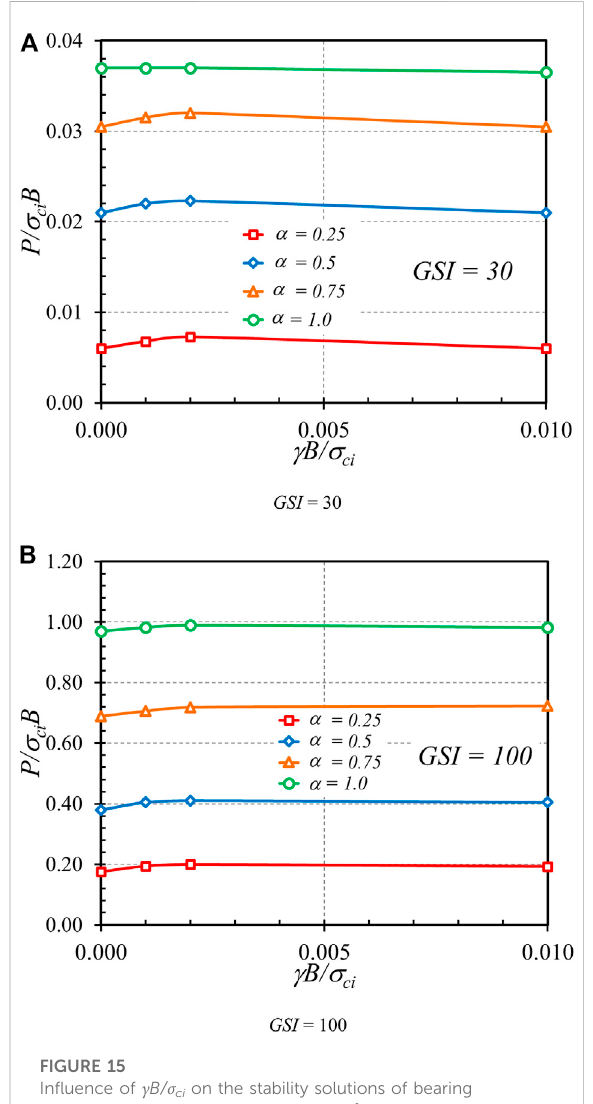
FIGURE 15 In fl uence of γ B/ σ ci on the stability solutions of bearing capacity factor on the rock mass ( β = 45 ° , e/B = 0, and m i = 5). (A) GSI = 30 (B) GSI = 100.